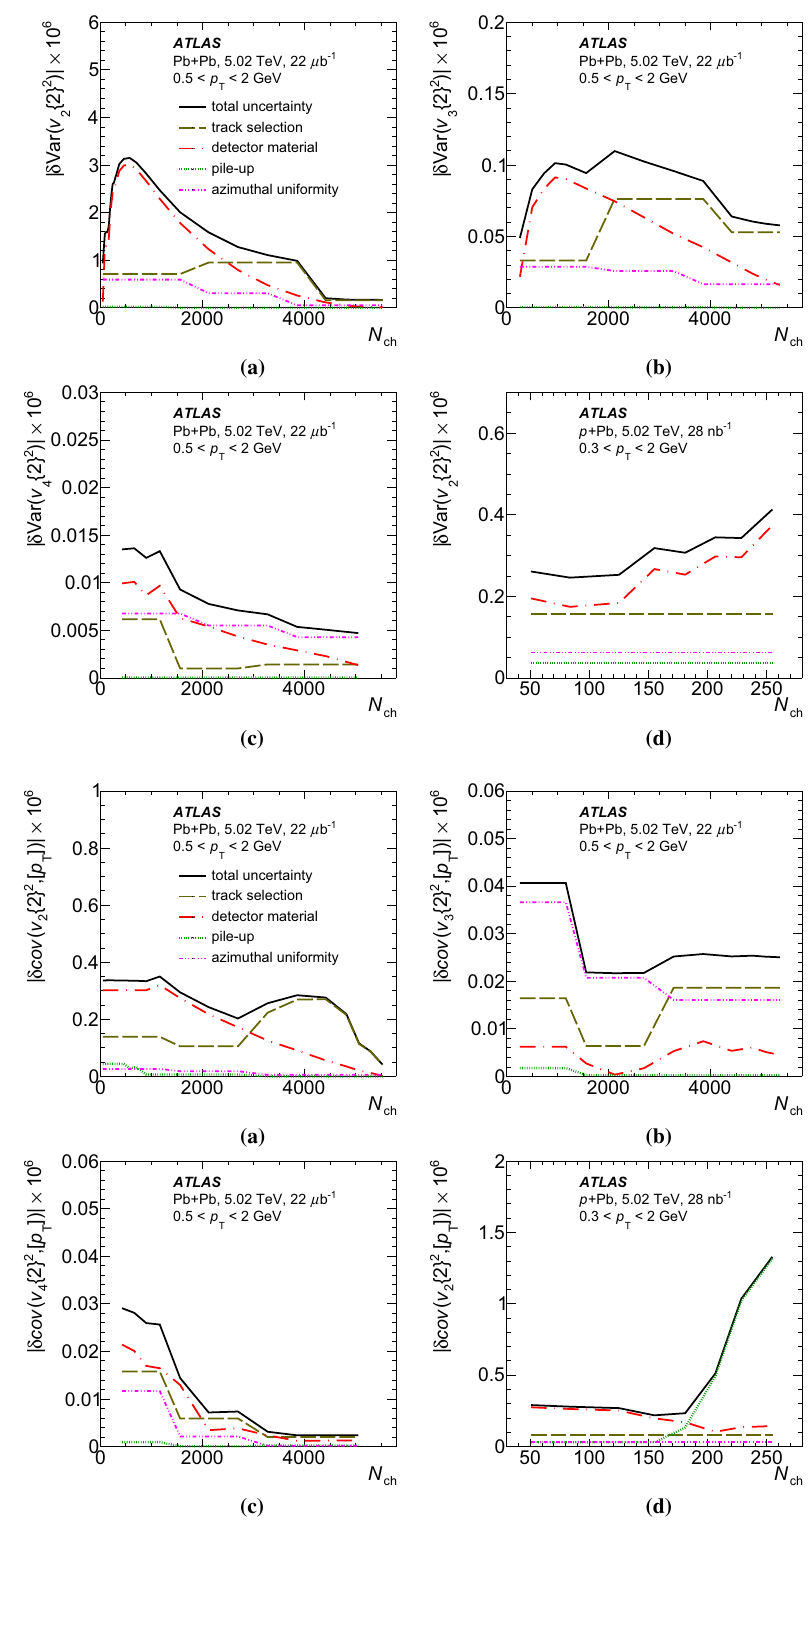
Fig. 9 The systematic (cid:4) (cid:3) v { 2 } 2 uncertainty of Var as n dyn a function of N ch measured with tracks from main p T intervals for each collision system for the a second, b third, and c fourth order harmonics in Pb+Pb collisions, and for d (cid:3) (cid:4) v { 2 } 2 Var in p +Pb 2 dyn collisions. The total uncertainty is also shown